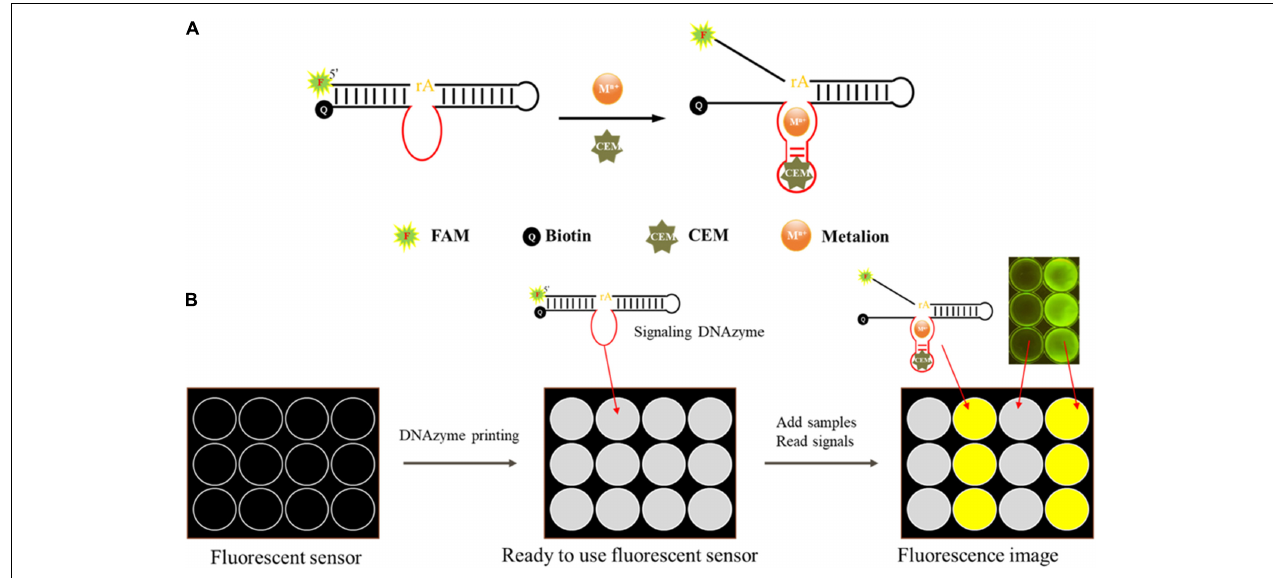
FIGURE 2 | Schematic of the mode of action of the DNAzyme and the envisioned DNAzyme sensor. (A) The DNAzyme becomes activated upon interaction with the bacteria-associated targets. The active DNAzyme then cleaves the fluorogenic substrate to produce a fluorescent signal. (B) A sensor was made to detect fluorescence. The DNAzyme sensor mixed with pullulan + trehalose + DNAzyme was taken into each well and air dried. Samples were then applied to the test zones and allowed to react. The DNAzyme cleaved the fluorogenic substrate and produced a fluorescent signal, which could be monitored using a fluorescent scanner and analyzed using specialized software when a sample contained the target